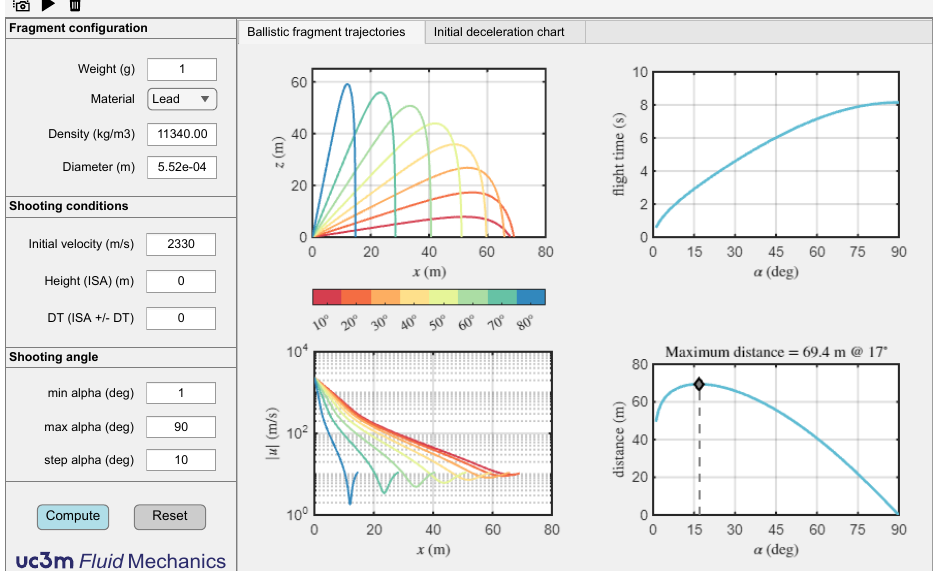
Figure 6. Interface of the primary fragment calculation assistant showing the ballistic fragment trajectory, flight time, velocity, and maximum distance charts. Fragments are assumed